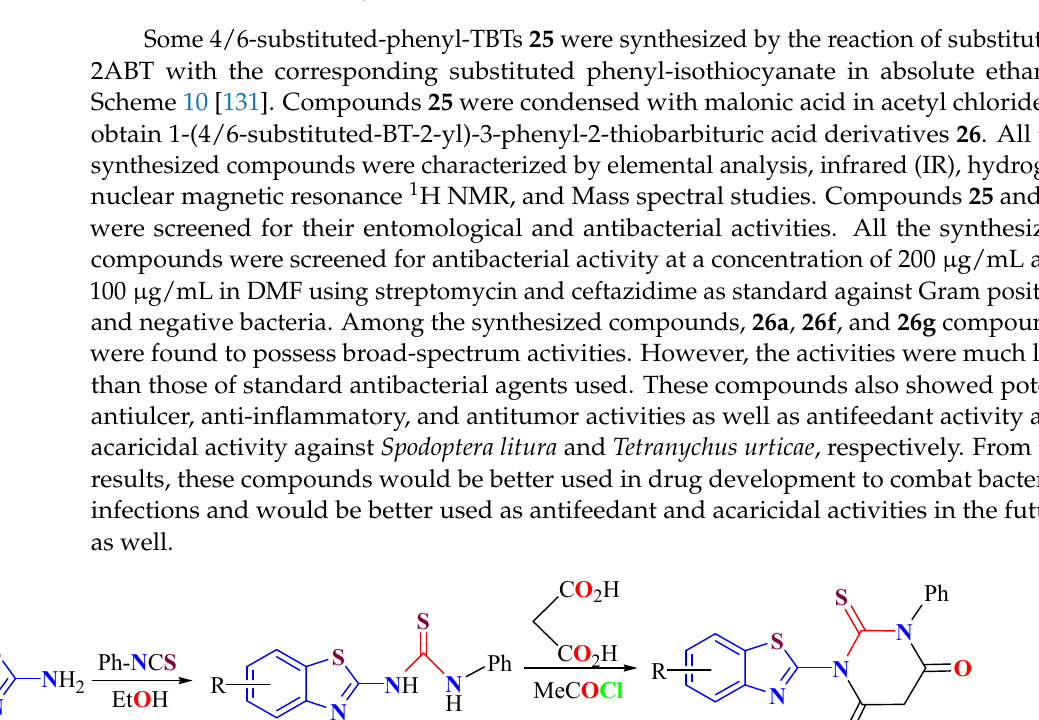
25 , , 6 Br , 6Me, 4Me, 6 O Et, 6 O Me, 6 F , 6C O H, R = 6 Cl , 6 NO 2 2 , 6 Br , 6Me, 4Me, 6 O Et, 6 O Me, 6 F , 6C O H, R = 6 Cl , 6 NO 2 2 Scheme 10. Synthesis of 4/6-substituted-phenylTBTs 25 to afford the thiobarbituric acid derivatives 26 . Firooznia et al., synthesized three 4,7-disubstituted-piperidine UBTs 27a – c from the re- action of the 4,7-disubstituted-2ABT with para nitro phenyl chloroformate, followed by the displacement of p -nitro-phenol with an appropriately substituted amine, Scheme 11 [132]. The synthesized compounds were evaluated for their selectivity against the A 2A and A 1 receptors. Antagonists of the A 2B receptor were used as potential therapeutic agents in mod- els of diabetes, asthma, chronic obstructive pulmonary disease (COPD), and pulmonary fibrosis. Compound 27c displayed excellent A 2B potency, as well as good A 2A and A 1 selec- tivity, IC 50 (A 2B cAMP) = 20 nm, Ki (A 1 binding) = 690 nm, and Ki (A 2A binding) = 530 nm. A SAR study revealed that compounds with urea derivatives, enhance A 2B potency. The 6-substituted-benzyl UBTs 28a – g were synthetized from the reaction of 6-substituted- 2ABT with the in situ generated substituted benzyl-isocyanates obtained from the benzy- lamine and triphosgene, Scheme 12 [133]. To improve yields, n -butyl-lithium was used to activate 2ABT (24–70%). In the case of 28g (R = CN), the 6-tetrazole p